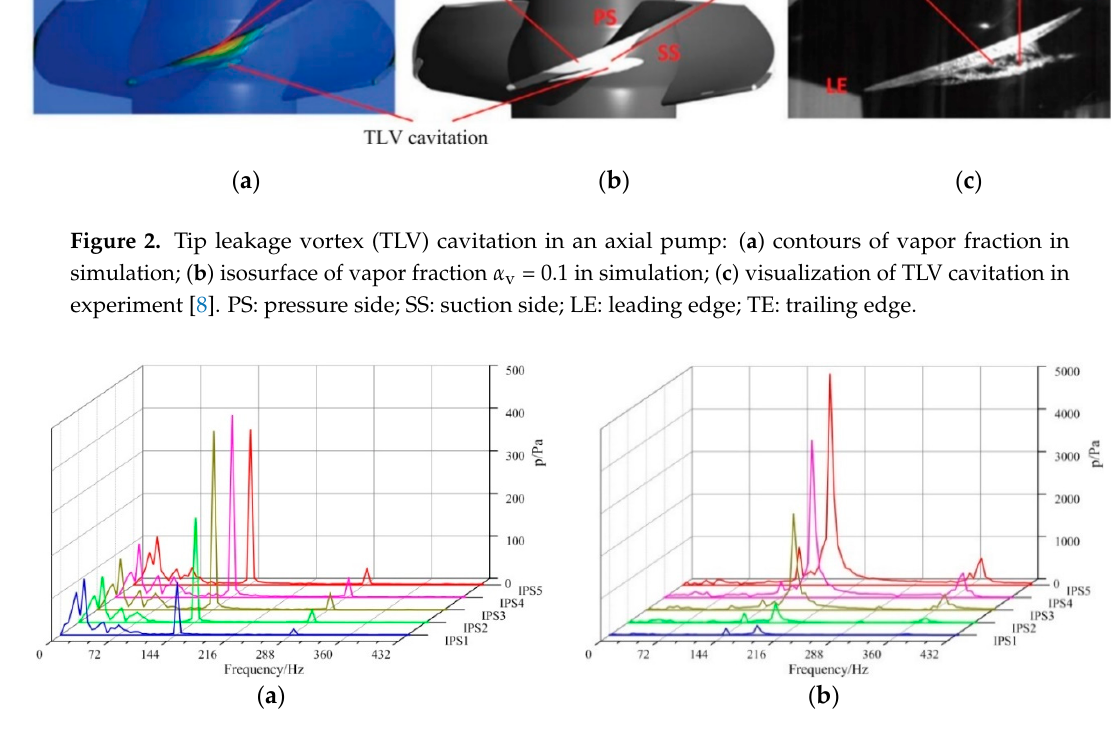
Figure 3. Comparison of pressure fluctuation on the blade pressure surface: ( a ) without tip clearance; ( b ) with tip clearance [5].